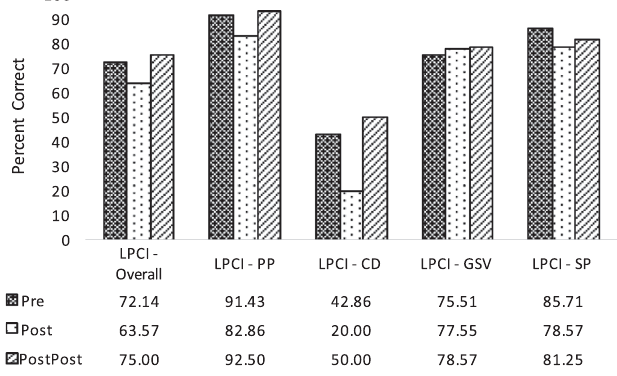
FIG. 5. Three snapshots (pre, post, and post-post) of percent correct of overall LPCI and by LPCI spatial domain for the eight 6th grade teachers who taught REAL.